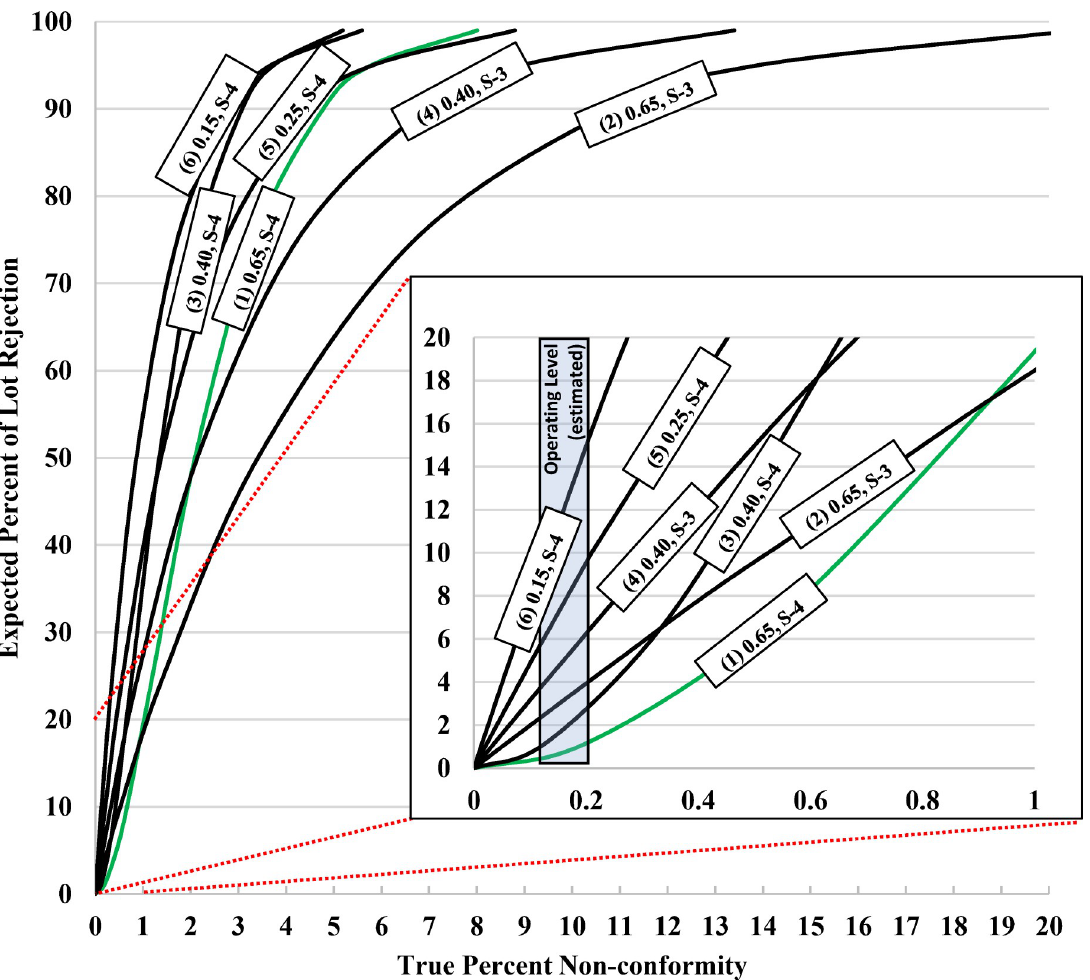
Fig 1. Operating characteristic curves from ISO 2859–1: 1999 for the lot size range of 35,001–500,000 for various sampling options (AQL, inspection level). For each AQL / inspection level provided in the figure, the respective number of samples and accept/reject ratio is listed as follows for single sampling plans at normal inspection: (1) 0.65, S-4, 80, 1/2 (green highlighted selected for use); (2) 0.65, S-3, 20, 0/1; (3) 0.40, S-4, 125, 1/2; (4) 0.40, S-3, 32, 0/1; (5) 0.25, S-4, 50, 0/1; (6) 0.15, S-4, 80, 0/1). Operating characteristic curve data in ISO-2859-1: 1999 is provided as expected percentage of lots to be accepted (%A) but presented here as an expected percentage of lots rejected (%R = 100 - %A) to visually correlate increases in percent non-conformity with increases in lot rejection.